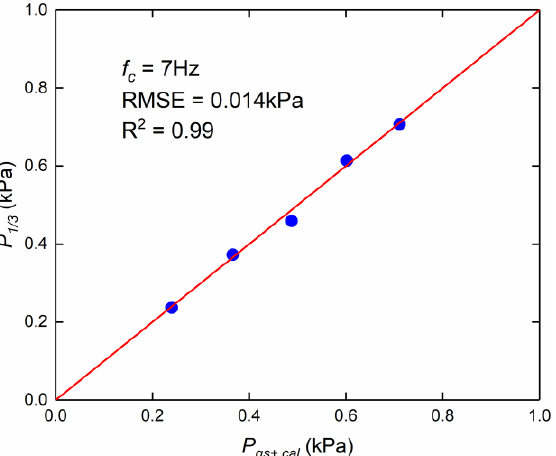
Figure 7. Comparisons between measured values P 1/3 of rebuilt pressure time series results and calculated values P qs+,cal from empirical formula for a cut-off frequency of 7 Hz.